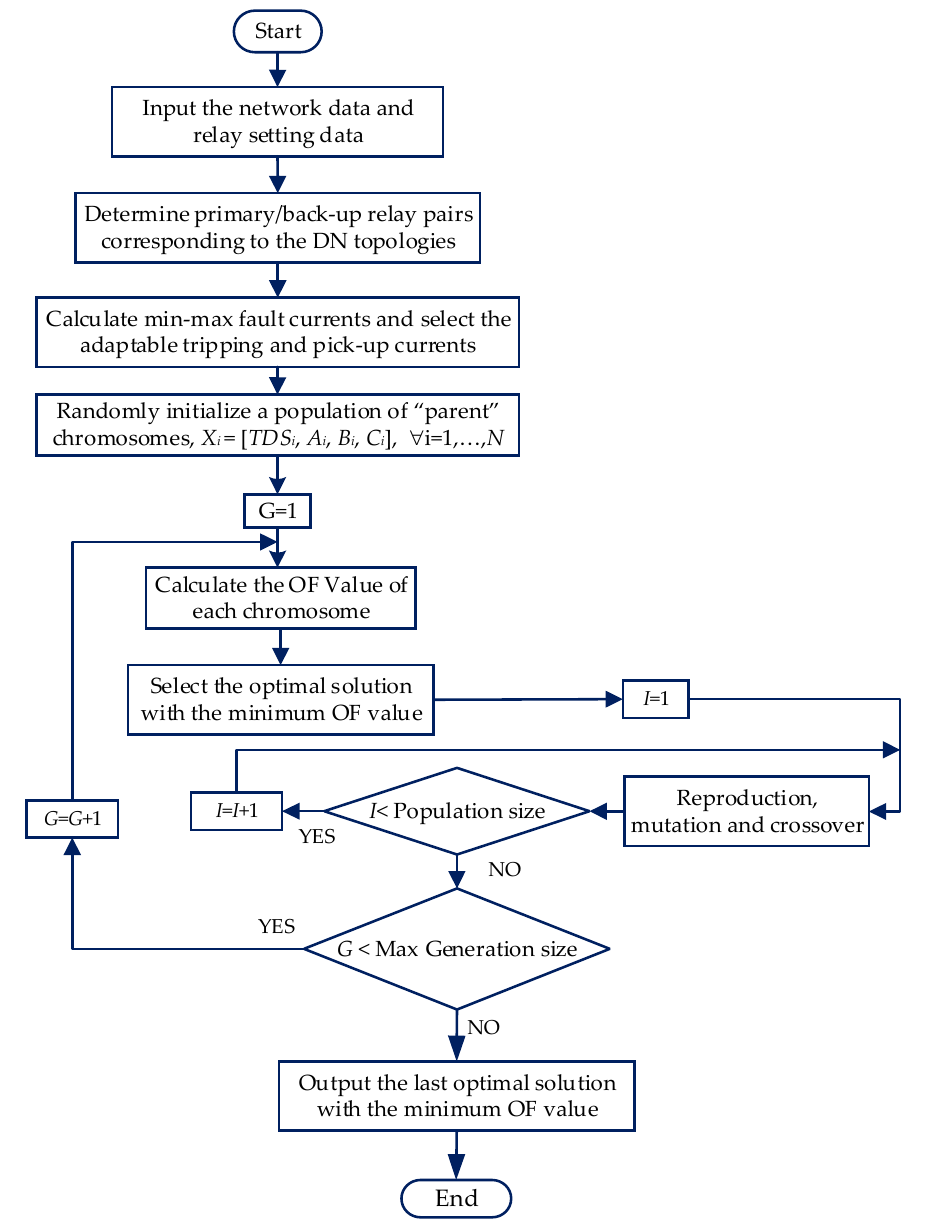
Figure 8. A flow chart of GA applied to the proposed ASPC approach of OCRs in the DN.